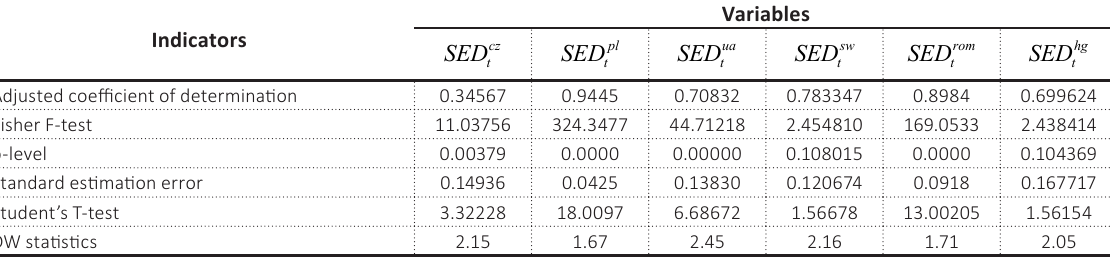
Table 7. Indicators of the significance of econometric research (vector regression modeling) of the banking sector’s impact on the socio-economic development of some EU countries, Switzerland, and Ukraine Source: Author’s calculations based on Appendix A and Table 6 using EViews 11